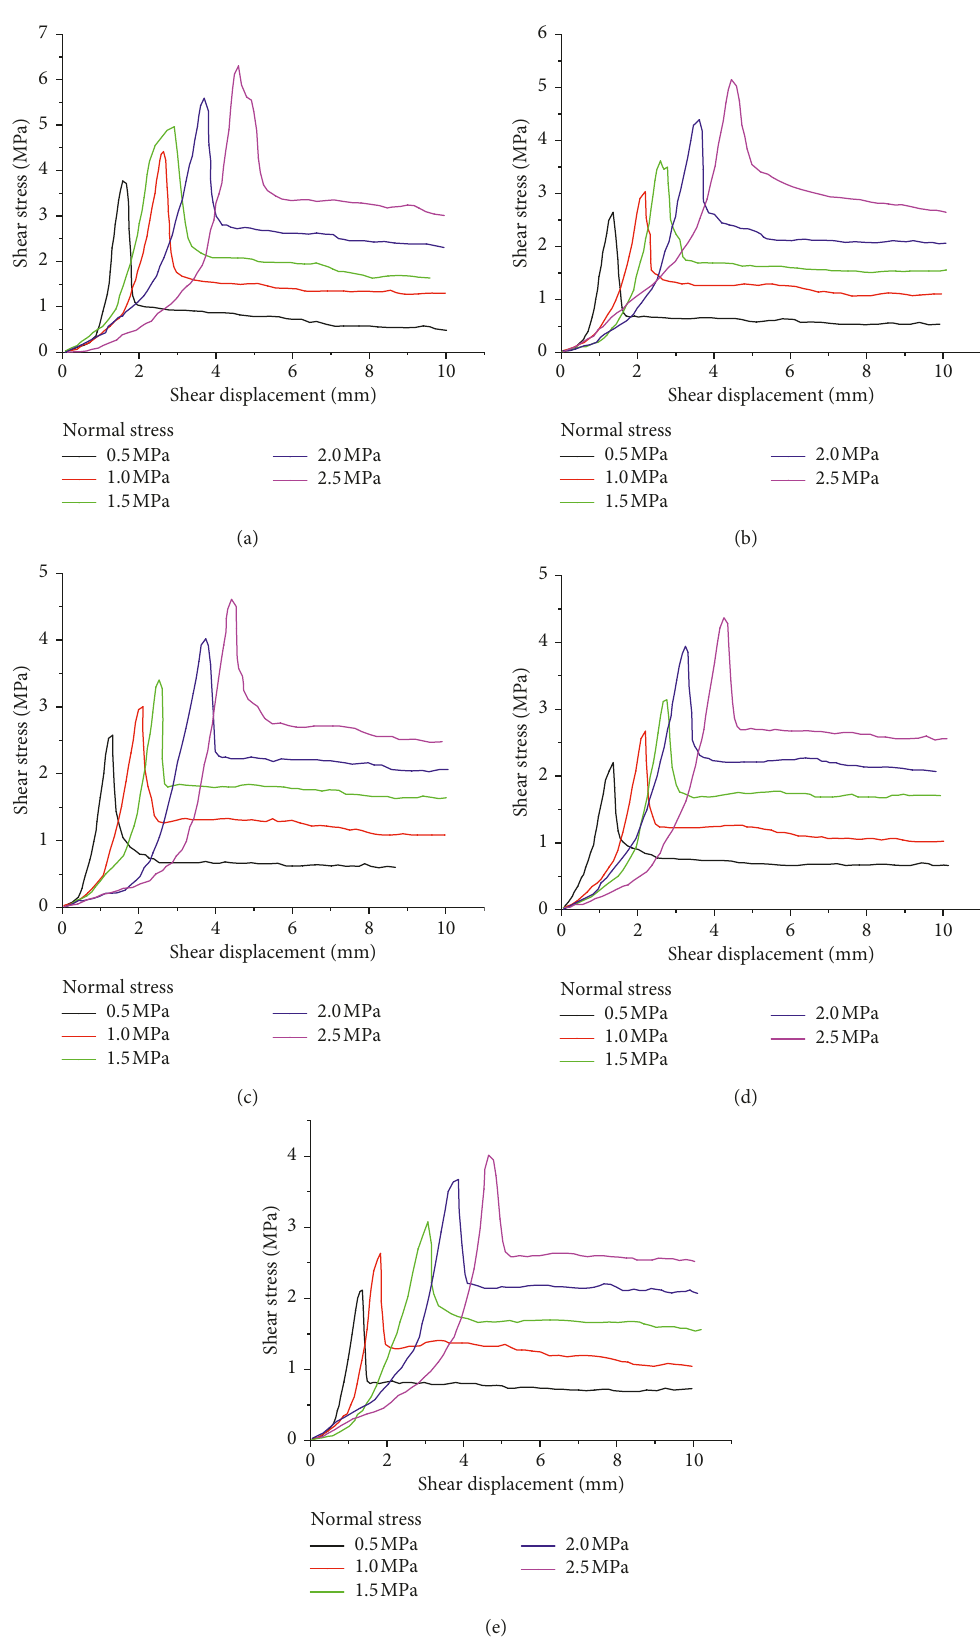
Figure 7: Relationship between shear stress and shear displacement of λ � 30% specimen with different normal stresses. Freeze-thaw cycles (a) 0 times, (b) 10 times, (c) 20 times, (d) 30 times, and (e) 40